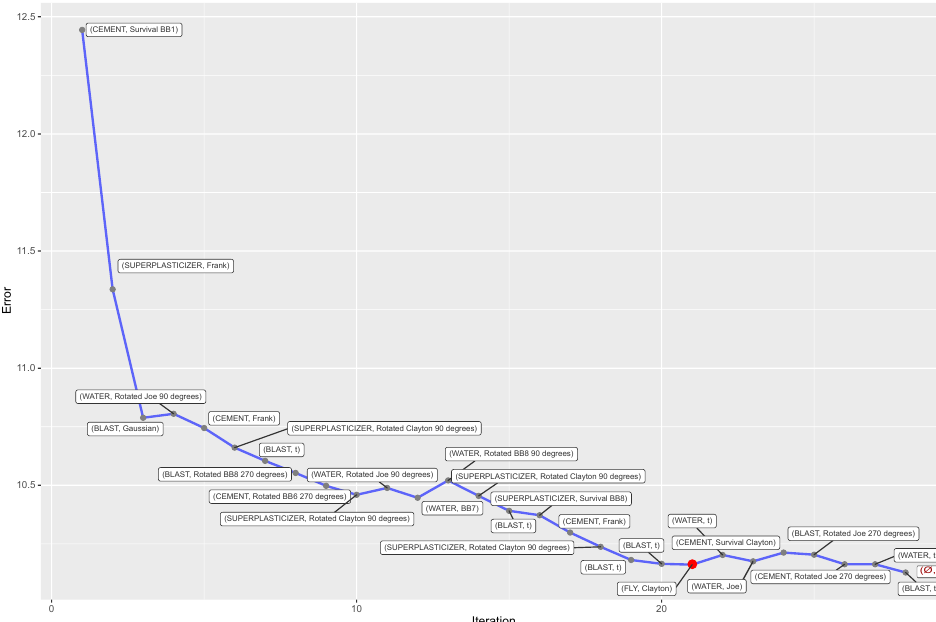
Figure 3. Evolution of MAE metric using ADABOC over a validation